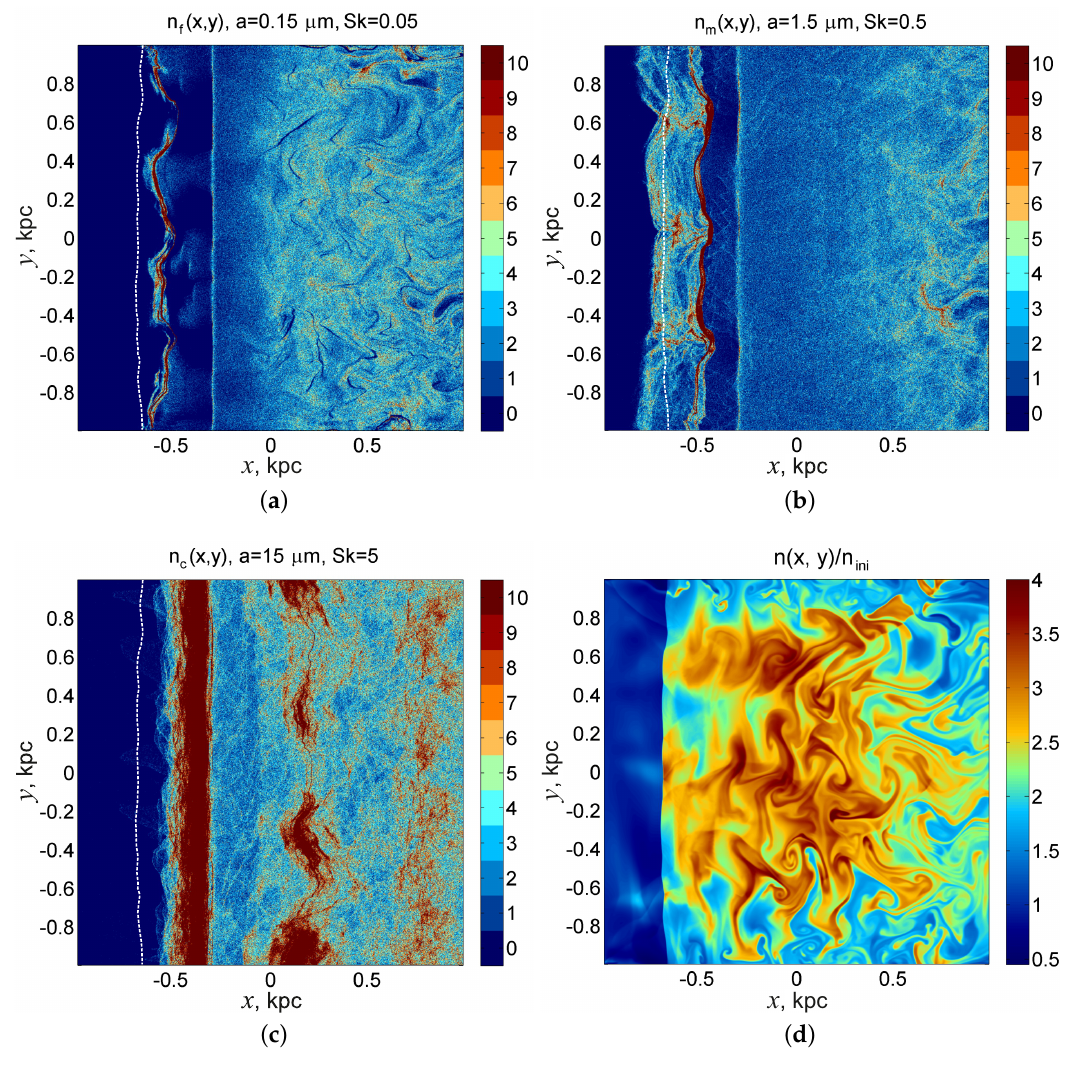
Figure 6. Distributions of concentrations of dust fractions at the same time after the establishment of dynamic equilibrium in the numerical model of gas-dust flow through the spiral arm of the galaxy. The gravitational well is located in the region − 1 ≤ x ≤ 1, is variable along the axis x and is homogeneous along y . The gas-dust mixture moves from left to right. Distributions are given for dust particles of different sizes: ( a ) fine dust particles with a radius of a = 0.15 µ m; ( b ) dust particles of a medium size with a radius of a = 1.5 µ m; ( c ) large specks, a = 15 µ m. The corresponding values of the Stokes numbers Sk are indicated in the headings to the figures. ( d ) shows the distribution of the gas density at the same time. The density is normalized to the density value at the entrance to the computational area. The white dashed line indicates the position of the front of the galactic shock wave for a given